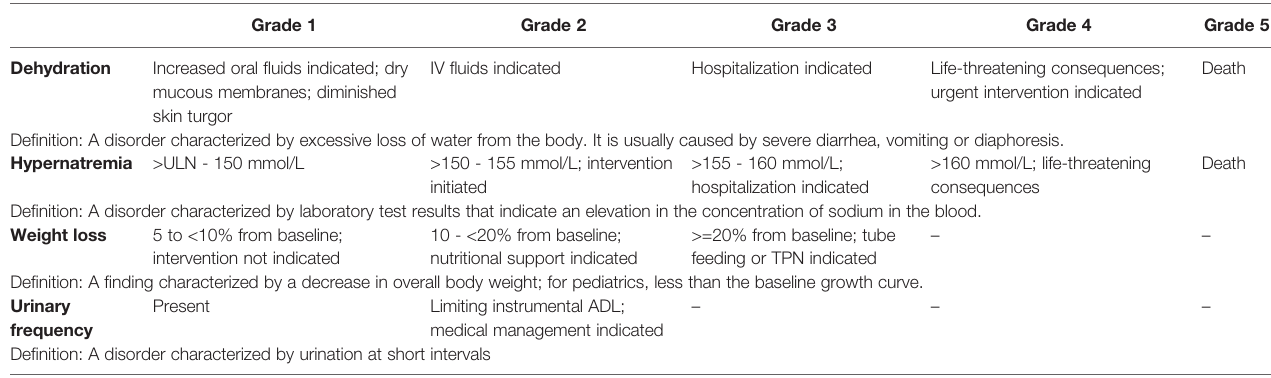
TABLE 2 | Toxicity level of the main symptoms (dehydration, hypernatremia, weight loss) of diabetes insipidus according to the current CTCAE grading system (version